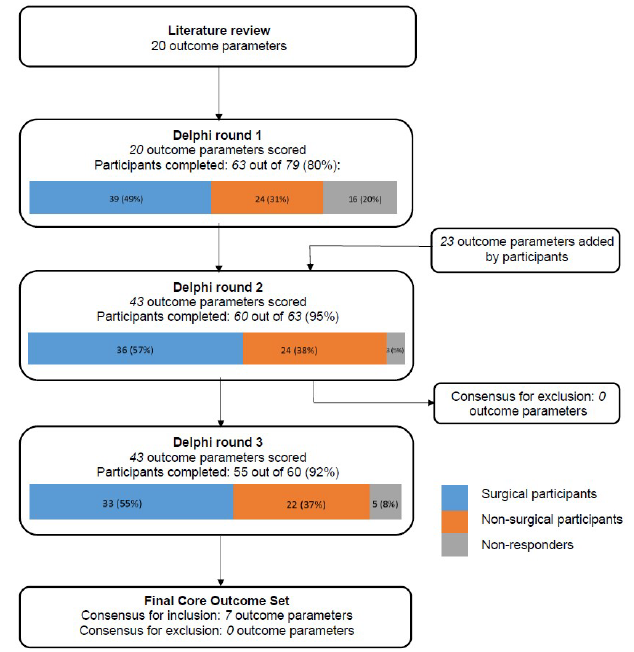
Figure 1. Flowchart of the 3-round Delphi Survey.